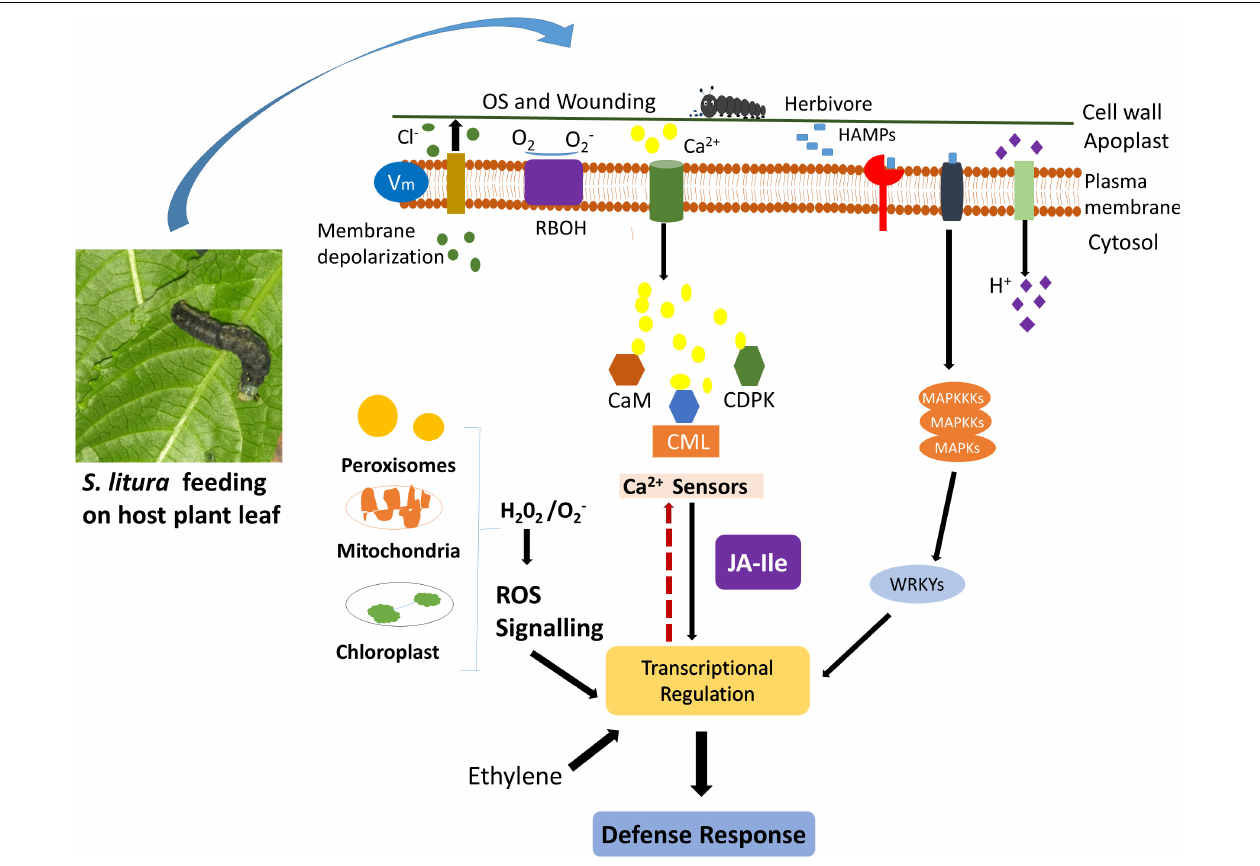
FIGURE 10 | Schematic representation of herbivory-induced early signaling events (calcium signaling, ROS generation, activation of MAPK Pathway) and involvement of CMLs in plant defense response against insect attack. Upon herbivory, plants perceive stimuli and instigate a couple of early events, such as activation of calcium signaling, induction of mitogen-activated protein kinase pathway, and generation of reactive oxygen species, which transduce the signal and activate the biosynthesis of other signaling and defensive compounds. In soybean, the expression of few GmCMLs, one of the crucial Ca 2 + sensors, is upregulated during S. litura -infestation. GmCMLs have Ca-EF hands, which allow them to sense calcium signature and bind with Ca 2 + , which can further regulate downstream signaling and activate plant defense